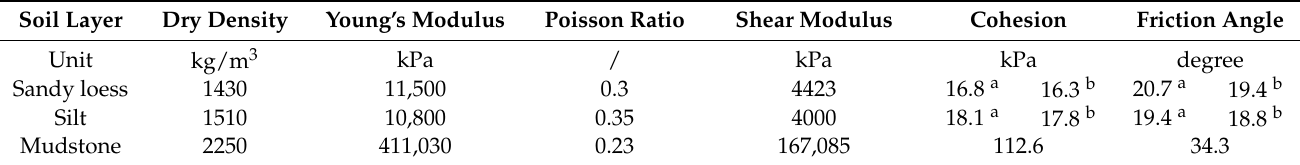
Table 2. Mechanical parameters and values for the numerical